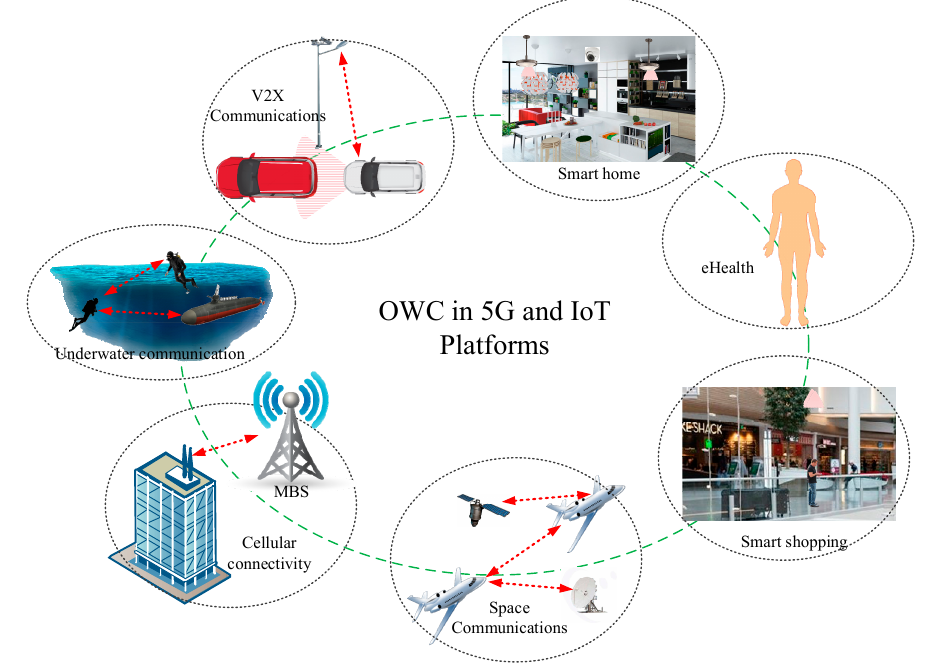
Figure 2. OWC networks for the 5G/6G and IoT platforms.